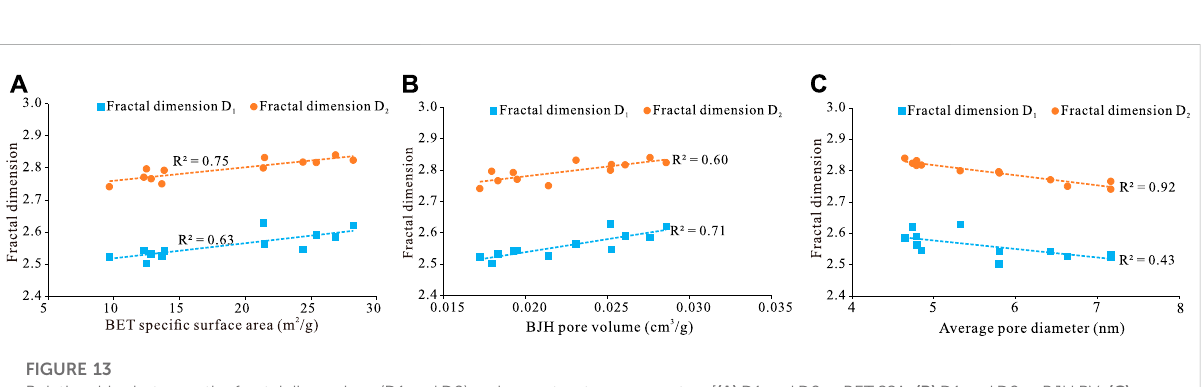
FIGURE 13 Relationshipsbetweenthefractaldimensions(D1andD2)andporestructureparameters[ (A) D1andD2vsBETSSA; (B) D1andD2vsBJHPV; (C) D1 and D2 vs